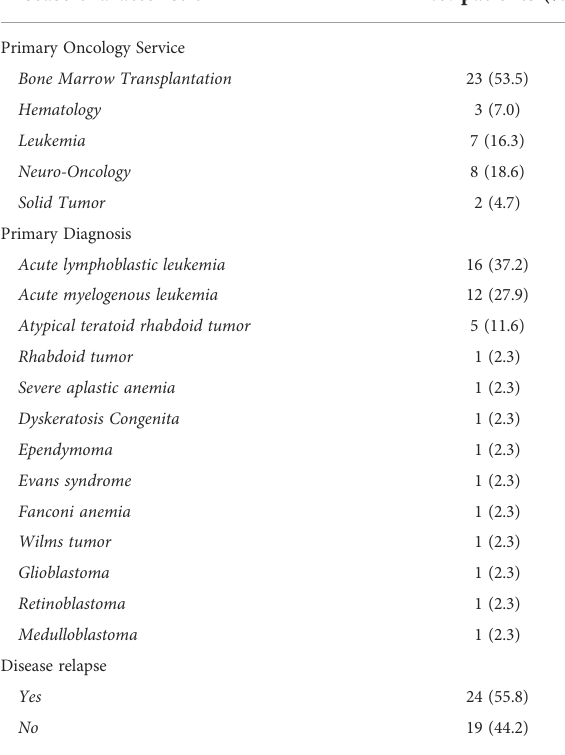
TABLE 2 Disease characteristics of 43 pediatric hematology/ oncology patients who received compassionate de-escalation of life- sustaining treatments. Disease